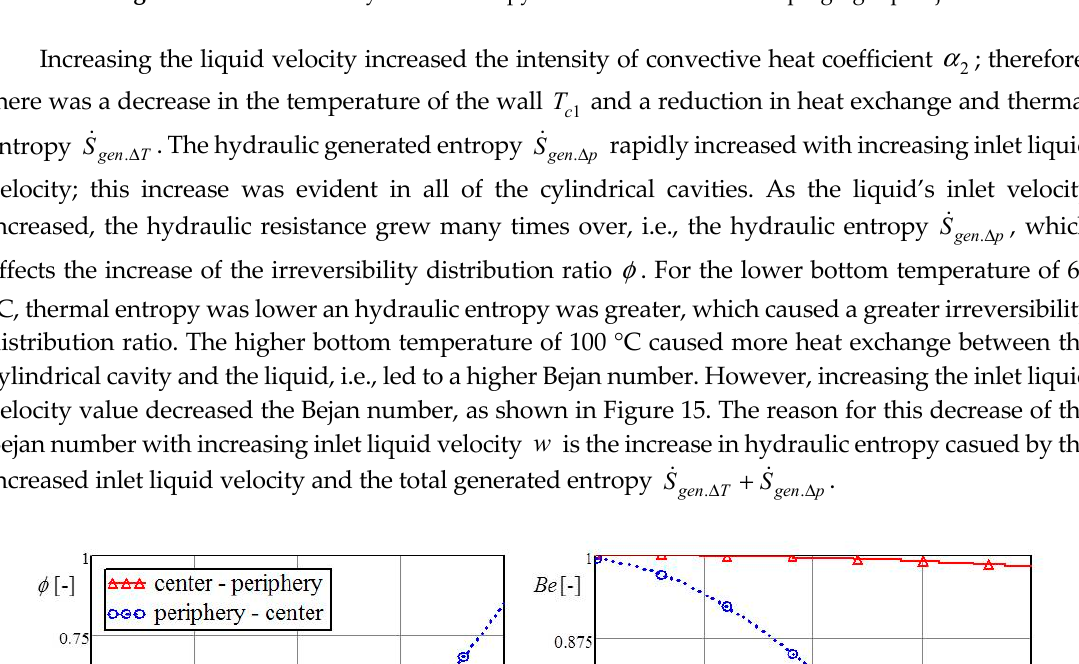
Figure 14. Thermal and hydraulic entropy for direct and counter impinging liquid jet.